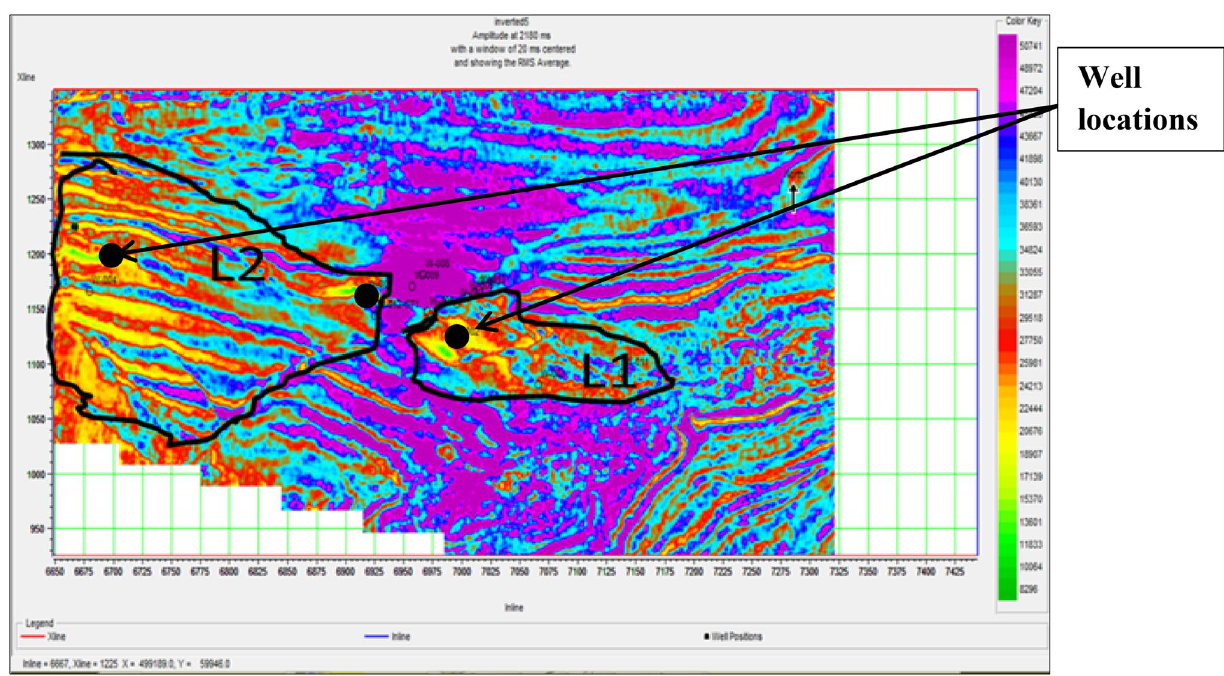
Fig. 5 Time slice (2180 ms) showing the distribution of acoustic impedance